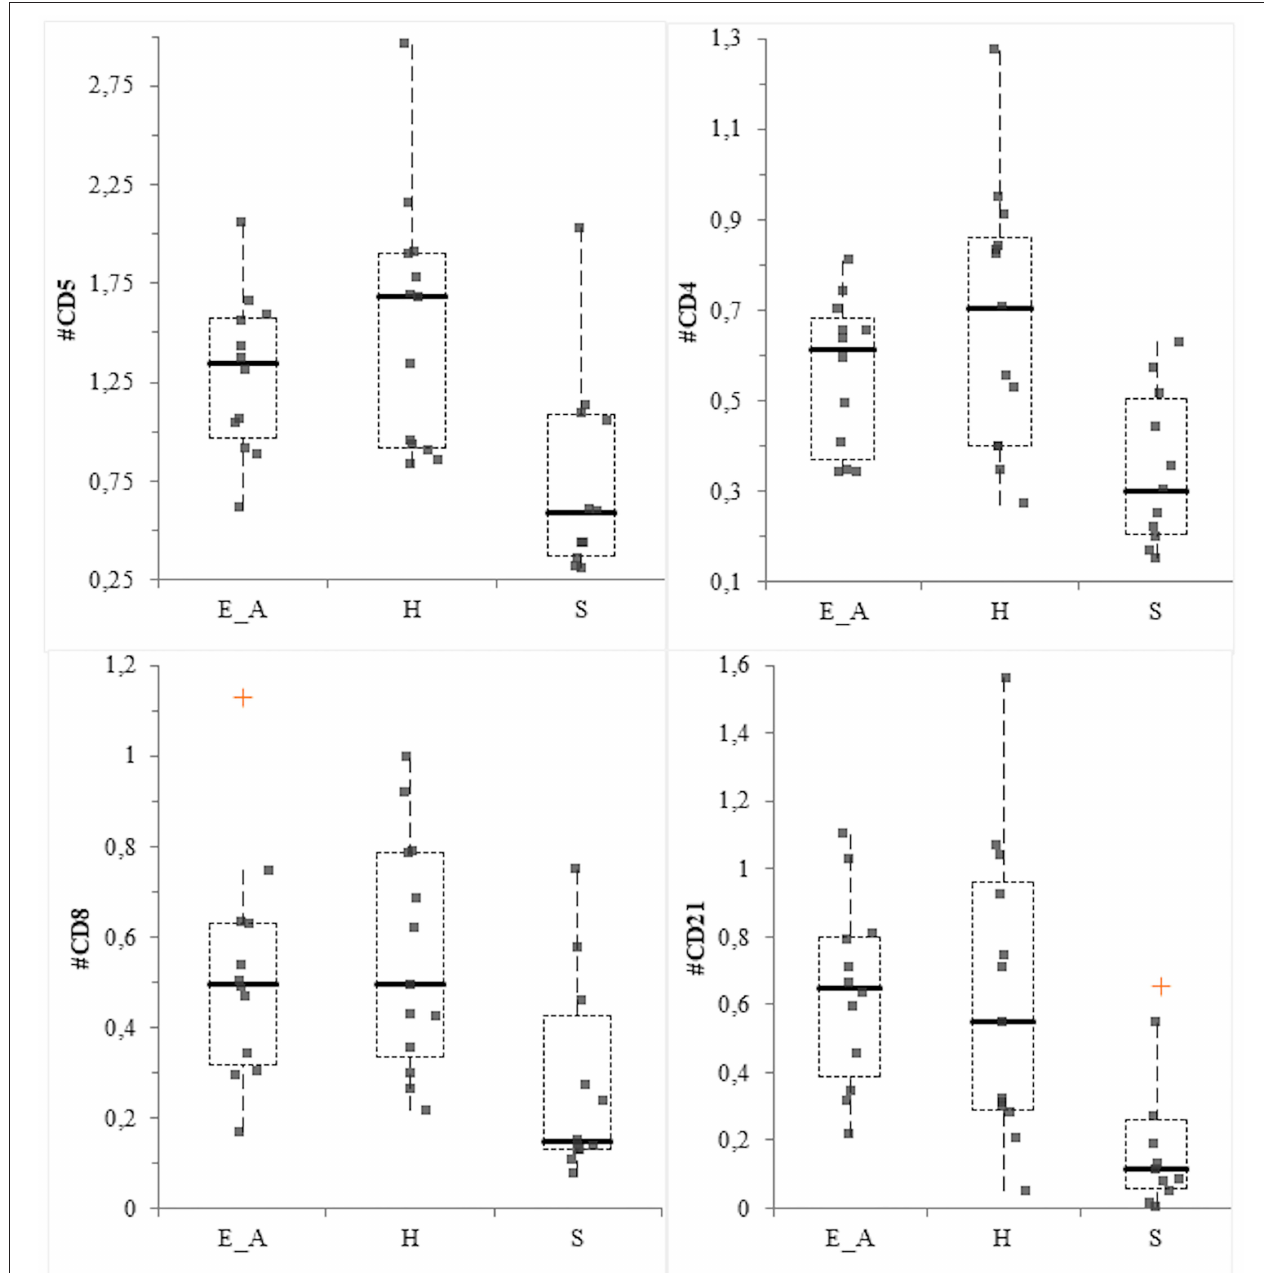
FIGURE 5 | Box—plot for main lymphocyte classes in the three group of dogs. Comparison of the absolute value (expressed as × 10 3 / µ L) of CD5 + cells (upper left), CD4 + cells (upper right), CD8 + (lower left) and CD21 + (lower right) cells among the three group. The orange crosses represent the near outliers.